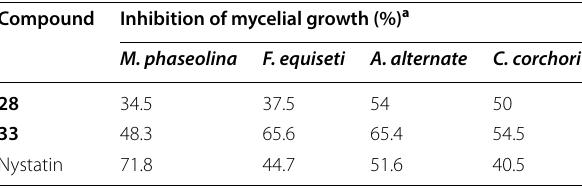
Table 8 Antifungal activity of some synthesized